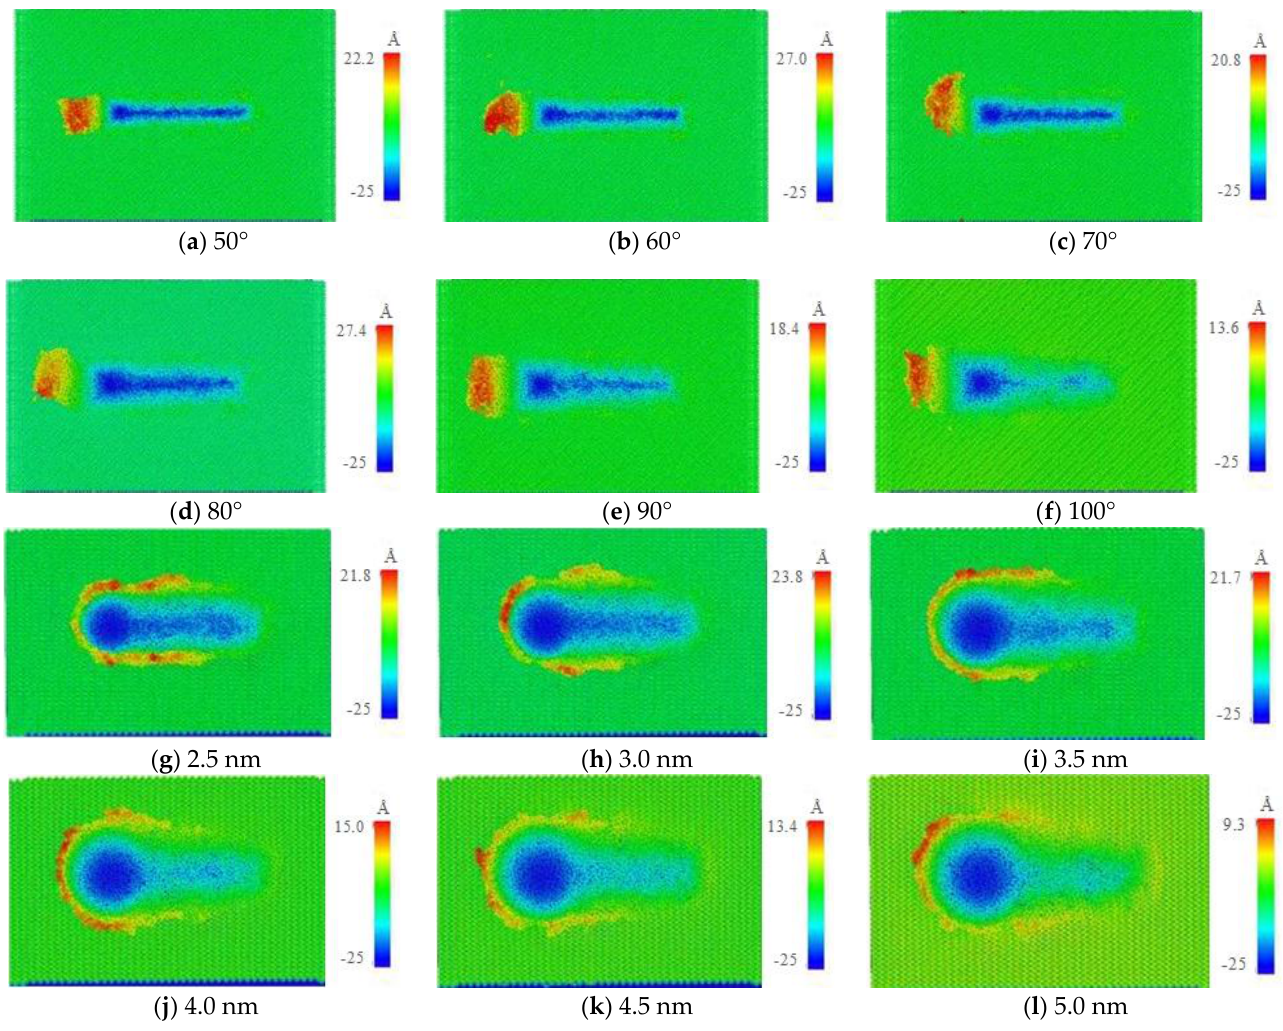
( b ) A sphere with a radius of 4.0 nm ( c ) Pyramidal agglomerated particles ( d ) Spherical agglomerated particles Figure 7. Scratch damage of agglomerated particles with different shapes. To investigate the effect of agglomerated particle size on scratch damage, pyramidal agglomerated particles with cone angles of 50°, 60°, 70°, 80°, 90°, and 100°, and spherical agglomerated particles with a radius of 3, 3.5, 4, 4.5, and 5.0 nm were selected for the scratch formation simulation. The results are shown in Figure 8. Here, it was clear that following the scratch process involving agglomerated particles with different shapes and sizes, the indentation depth was always 2.0 nm, while atomic accumulation tended to oc- cur on the substrate surface. However, with the increase in cone angle or particle radius,